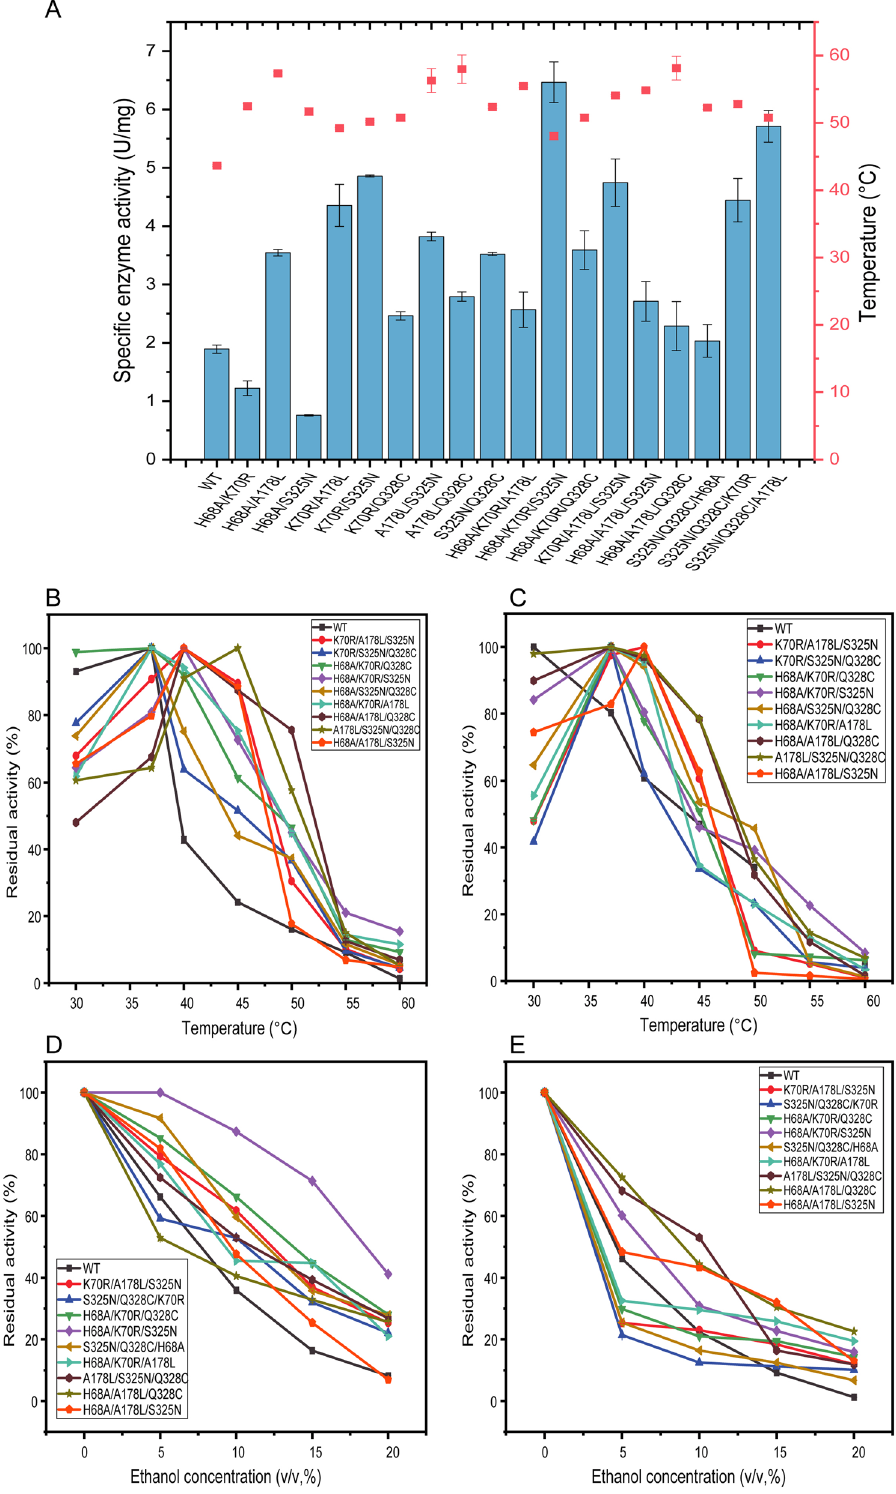
Fig. 3 Diagram of the enzymatic properties of the three mutant proteins. ( A ) Specific enzymatic activity and T m values of double and triple mutant proteins. B Optimal temperature of the triple mutant proteins. C Temperature stability of the triple mutant proteins. D Ethanol tolerance of the triple mutant proteins. E Ethanol stability of the triple mutant